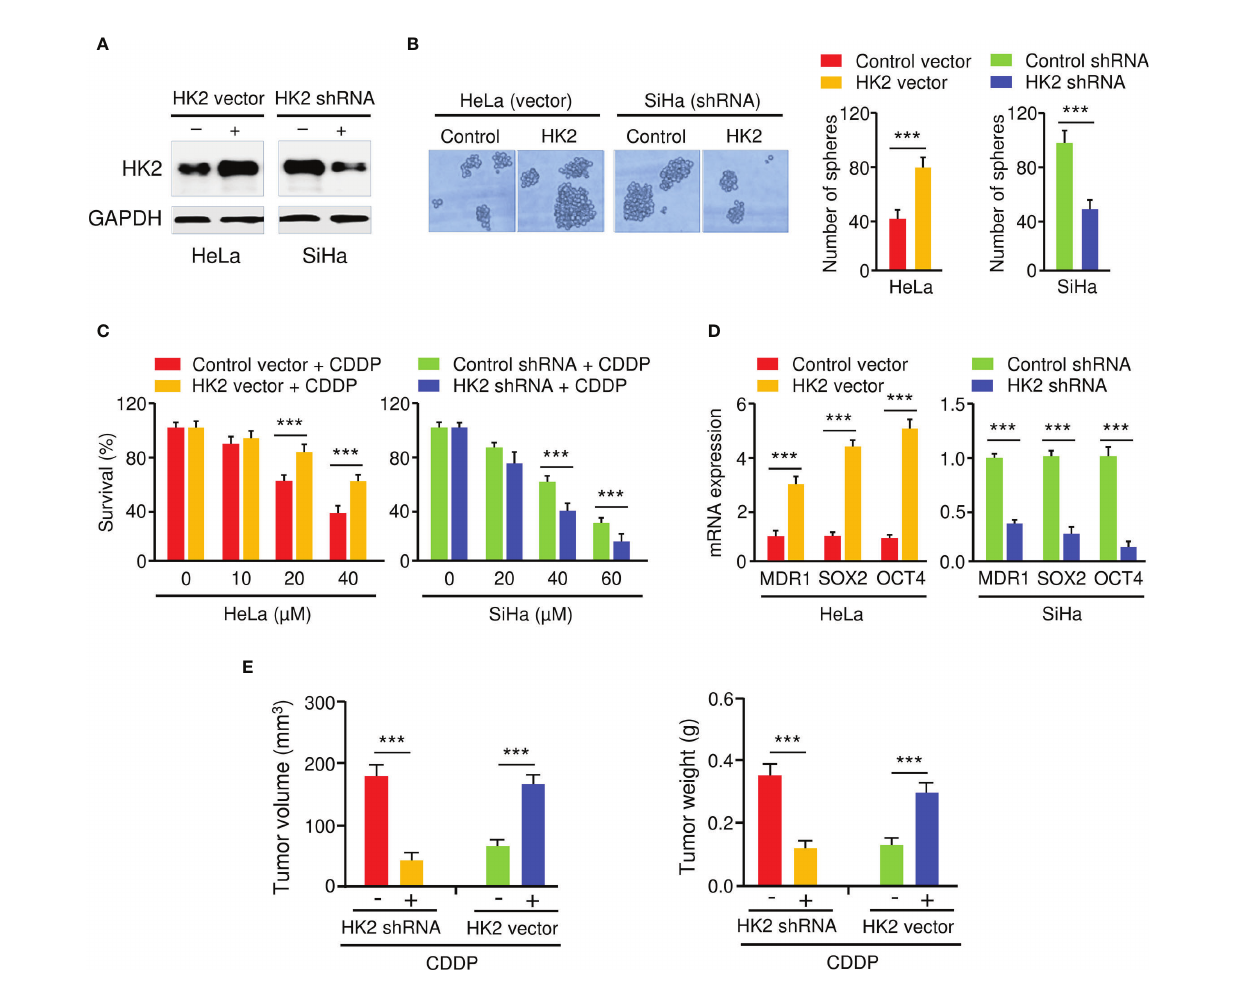
FIGURE 2 | HK2Promotes Sphere Formation and CDDPResistance in CC Cells. (A) Westernblot analysis of HK2expression inCC cells transfected as indicated. (B) The effect of HK2expression on the sphere formation was investigated using sphere formation assays. (C) Cellviability assay inresponse to CDDP treatment was determined usingCCK-8 assay. (D) The expression of MDR1, SOX2, and OCT4 in CC cells transfectedas indicatedwas detectedby the qRT-PCR assay. (E) HK2 overexpression (or knockdown) decreased(or increased) the sensitivity of CC cellsto CDDP in vivo . Tumor volume (left) and weight (right) were examined. *** P <